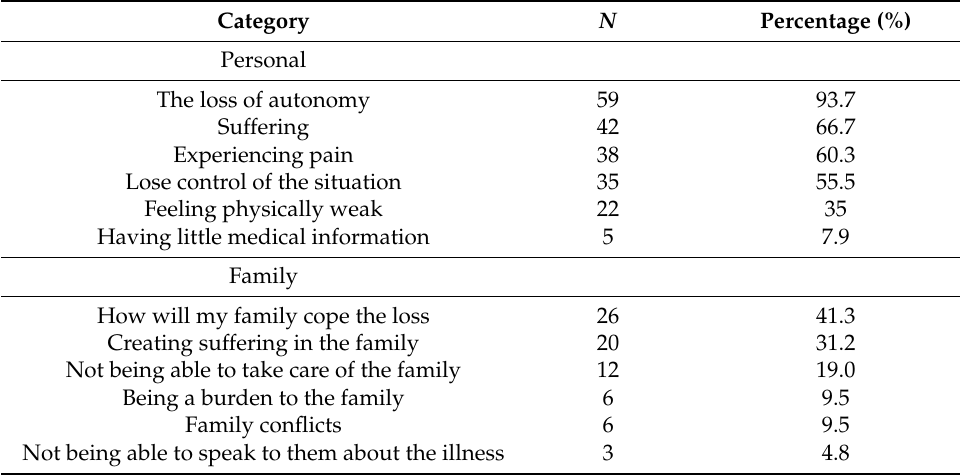
Table 3. Patient concerns ( n = 63) expressed in the open interview, grouped into categories ( n = number of participants that show concern, percentage in relation to the total amount of interviewed